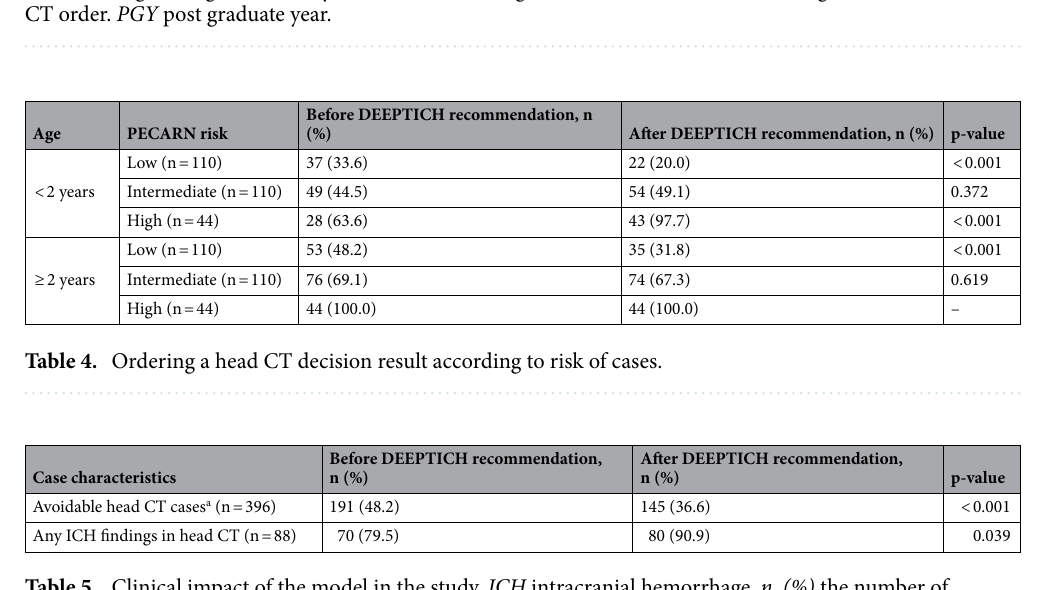
Table 5. Clinical impact of the model in the study. ICH intracranial hemorrhage, n, (%) the number of responses who answered ordering a head CT. a Avoidable head CT cases were defined as those whose CT results were finally negative in a low and intermediate